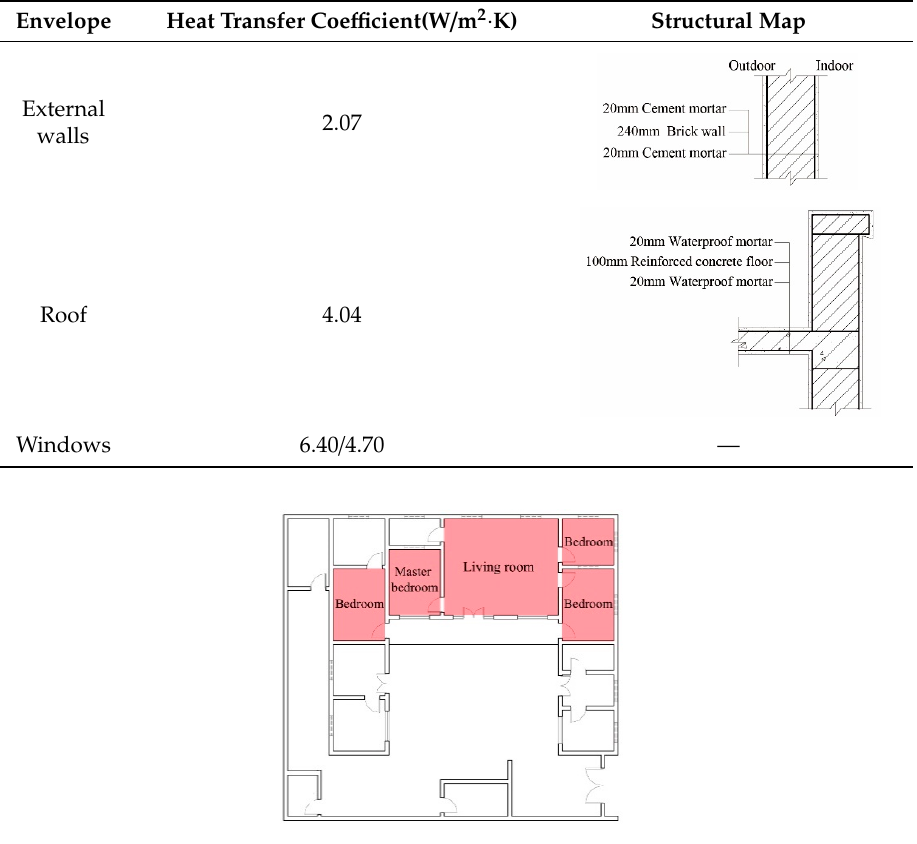
Table 2. Building envelope information of Rural House 2.